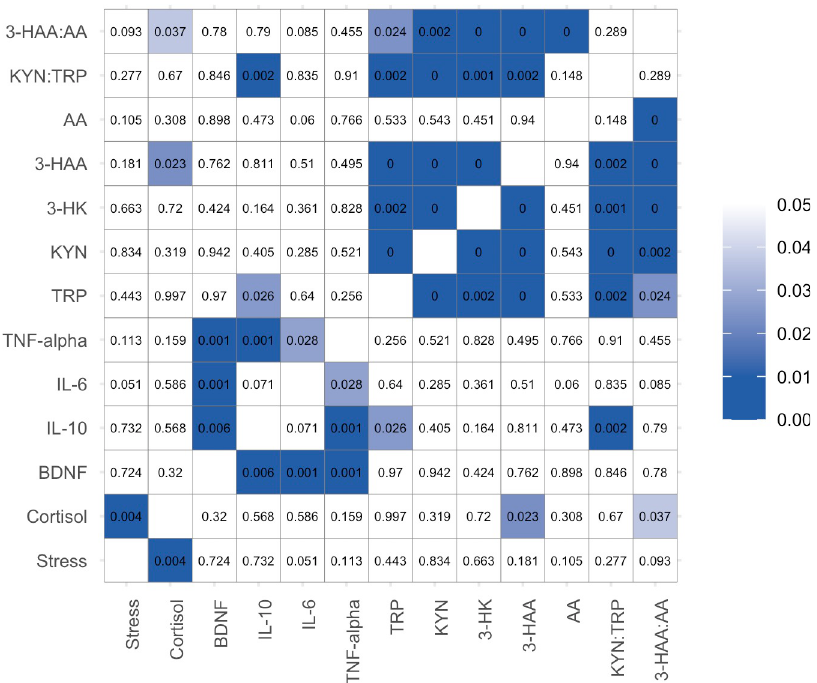
Fig 3. Correlation matrix showing p values between perceived stress scores, the levels of cortisol and BDNF, cytokines, and TRP and KP metabolites during post-examination period.